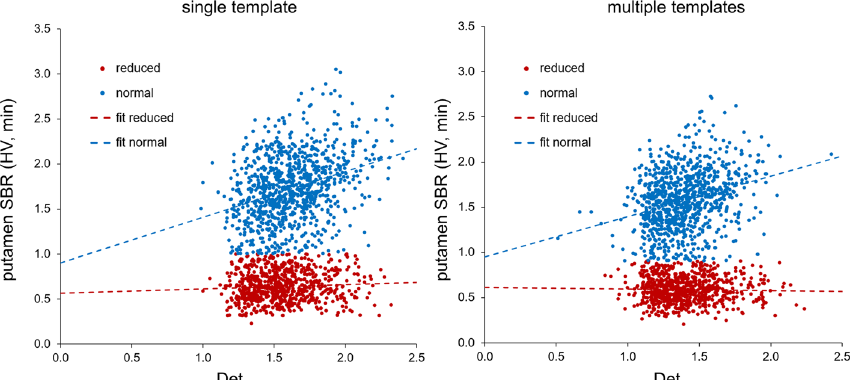
Fig. 4 Scatter plots of the putamen SBR versus the amount of stretching by stereotactical normalization. The scatter plots of the minimum putamen SBR from hottest voxels analysis versus the DET of the affine transformation for stereotactical normalization are shown separately for single (left) and multiple (right) templates. The dashed lines indicate the result of linear regression, separately for normal and reduced